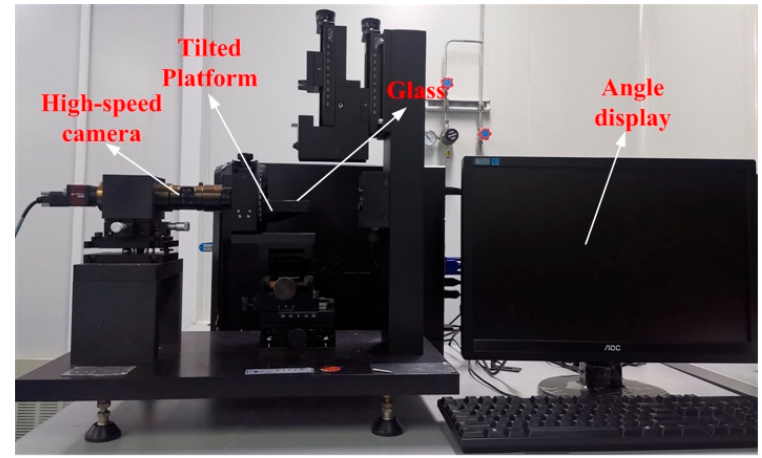
Figure 11. The platform of the sliding angle test.